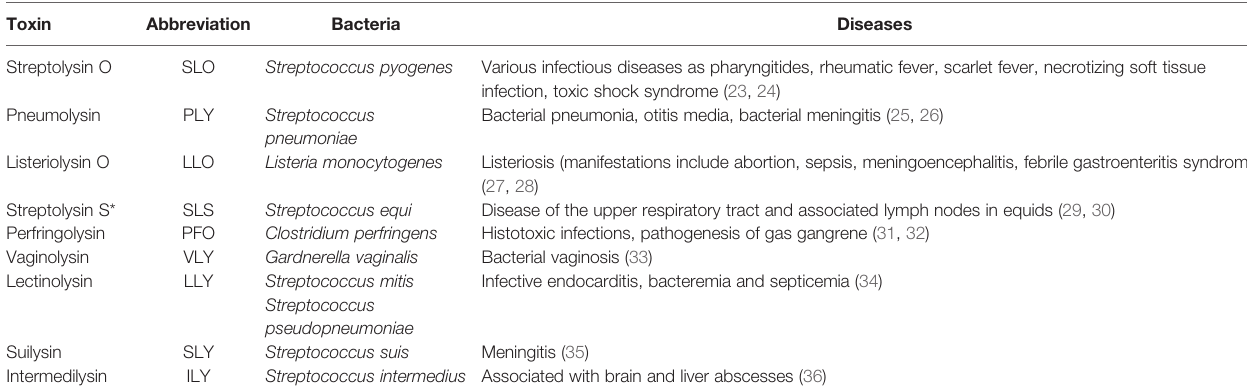
TABLE 1 | Summary of cytolysins discussed in this review, their bacterial producers, and a subset of associated